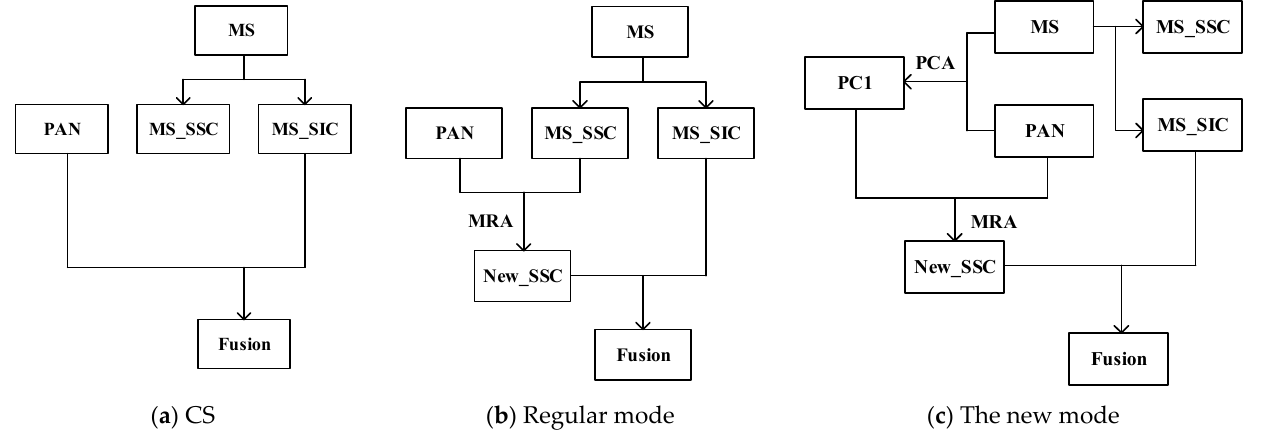
Figure 1. Hybrid model of the CS method and MRA method.